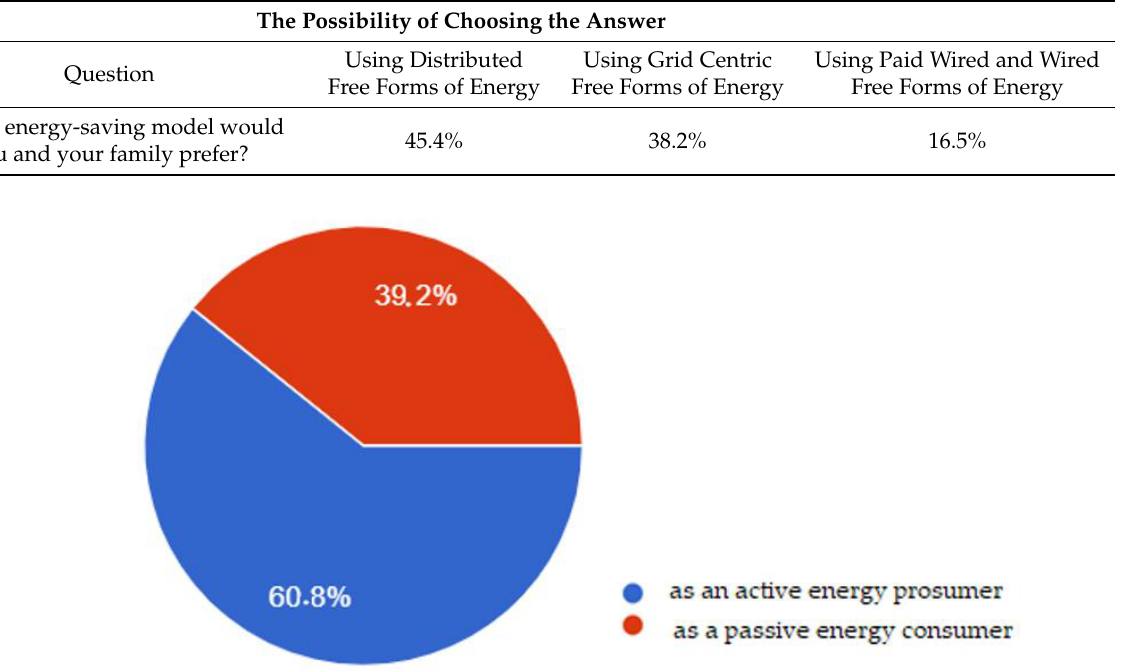
Figure 3. Which energy-saving model would you and your family prefer? Table 9. Question no. 9, research results. Table 8. Question no. 8, research results.